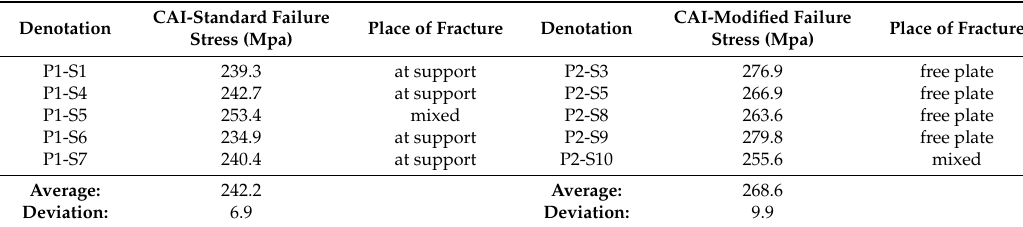
Figure 4. Observable failures on the surface of the specimen front side tested with CAI-modified (boundary conditions are described in Figure 2a) for the specimens P2-S3, P2-S5, P2-S8, P2-S9 and P2-S10. Table 1. Failure loads and place of fracture (also indicated in Figures 3 and 4) of different specimens for devices CAI-standard as well as CAI-modified with mean failure stress and standard